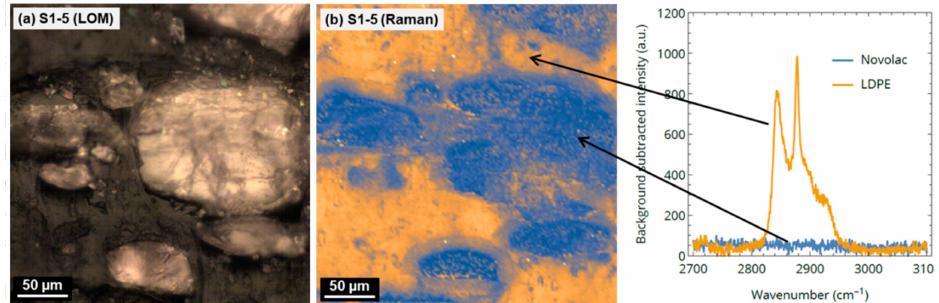
Figure 3. ( a ) Light optical microscopic (LOM) image of S1-5; ( b ) Raman mapping image of the same sample position, and background-corrected Raman spectra of LDPE and novolac. Blue regions in the Raman image indicate novolac (bright in LOM image), orange regions indicate LDPE (dark in LOM image).